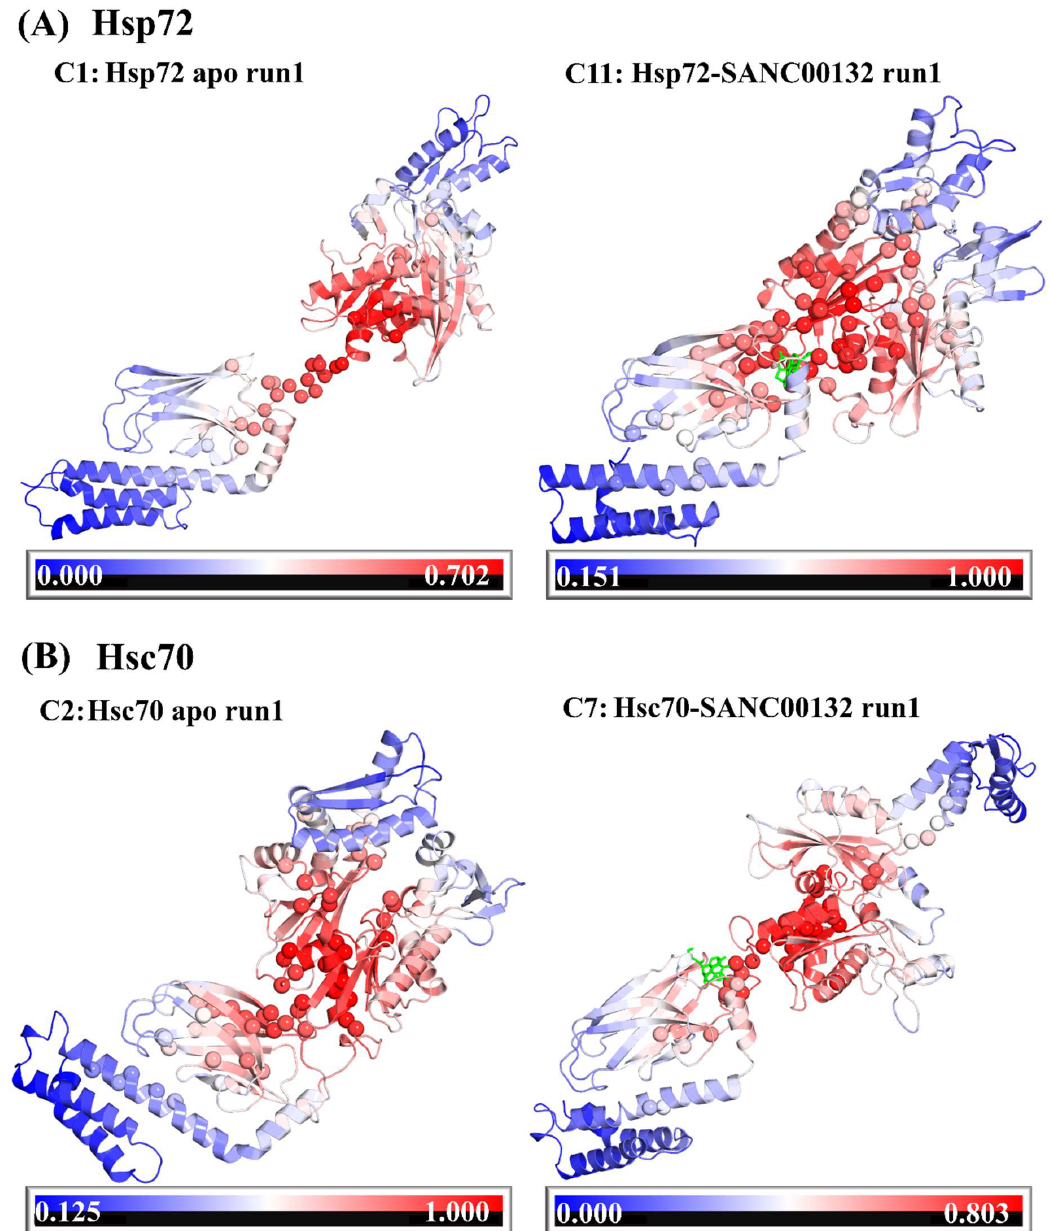
Figure 6. Structural mapping of average L and average BC on SANC00132-free and SANC00132-bound Hsp72 and Hsc70 representative structures. Structures were retrieved from the largest clusters occupying important free-energy basins conformers ( A : C1 (73 ns), C11 (82 ns), and B : C2 (56 ns), C7 (96 ns) in relation to Figure 3). Structures were coloured based on normalised average L values from red (lowest value; highly accessible) to blue (highest value; limited accessibility). Residues bearing the highest BC indices are indicated as spheres. First, both Hsp72 and Hsc70 images depict the global effects of ligand binding on structure compaction as described by Rg and interdomain distance results. Binding of SANC00132 to Hsp72 promotes intraprotein reorganisation from a loosely packed (more elongated) ligand-free 3D structure to a more compact complex. The opposite holds true for Hsc70. Second, it is evident that residue communities with significant average L and average BC values are populated at the interdomain linker, nucleotide, and substrate binding sites. SANC00132 is represented in sticks and coloured green.